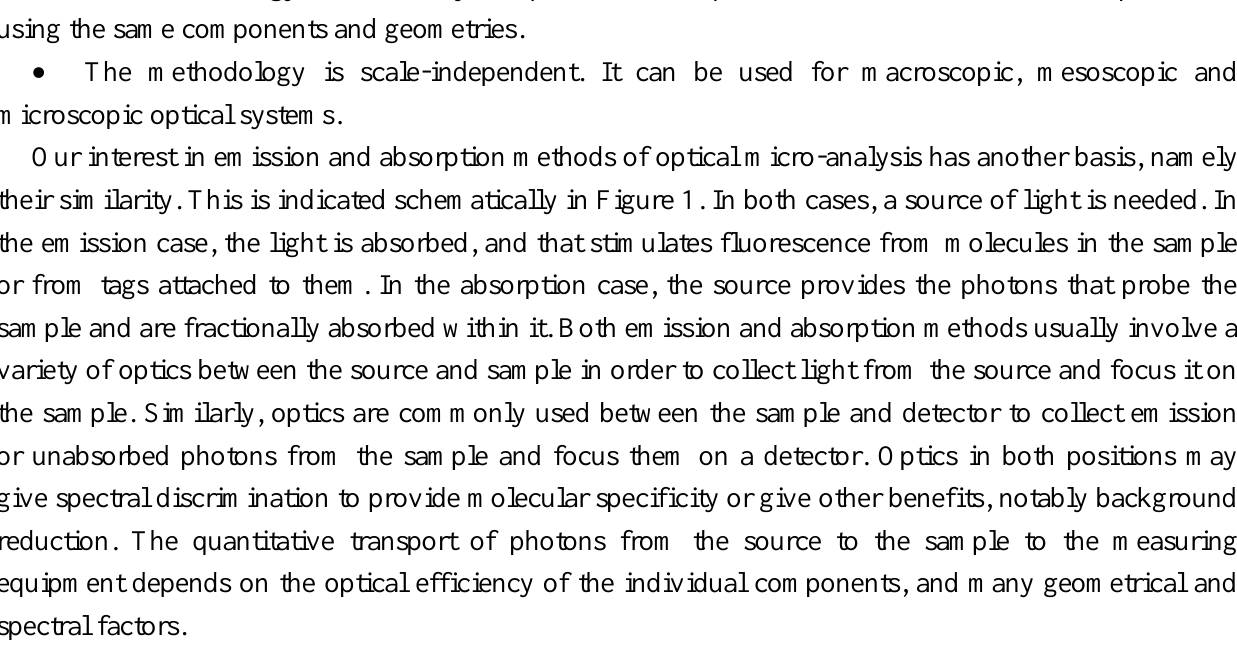
Figure 1. The sequence of major components in an optical micro-analytical system. For emission measurements, the source light goes as far as the sample, where the new fluorescent light originates. For absorption measurements, the two sets of optics and the sample can be thought of as the entire optical system coupling the source to the detector.